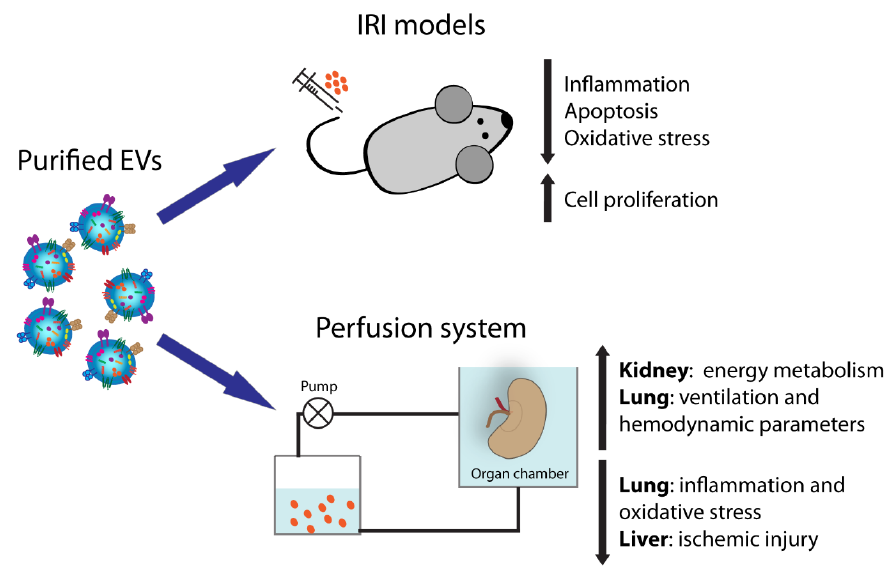
Figure 1. Extracellular vesicle (EV) activities in solid organ transplantation.